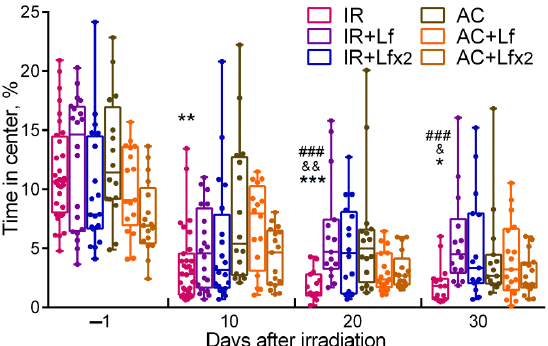
Figure 5. Effect of Lf on mouse behavior in the open field test after 7.5 Gy whole-body gamma irradiation. Lf (i.p.; 4 mg/mouse) was administered immediately after irradiation/sham-irradiation (IR+Lf, IR+Lf × 2, AC+Lf, AC+Lf × 2) and 24 h after it (IR+Lf × 2, AC+Lf × 2). Percent time spent in the center. Each dot represents a single animal. n = 32, 20, 20 (day − 1; for IR, IR+Lf, and IR+Lf × 2, respectively); n = 17 (for AC, AC+Lf, and AC+Lf × 2). Data are presented as the median, quartiles, and min–max range. * p < 0.05, ** p < 0.01, *** p < 0.001 in comparison with the AC group; ### p < 0.001 in